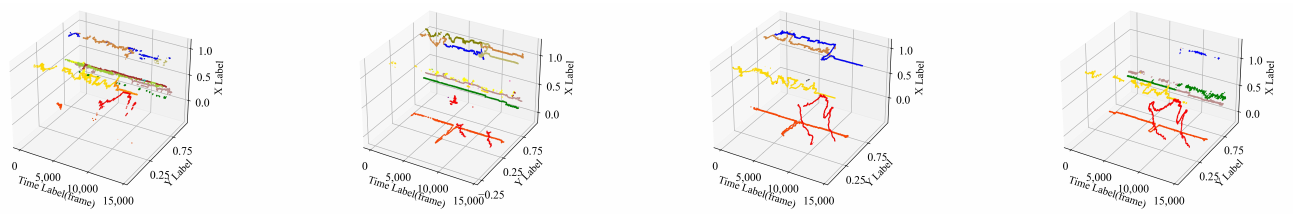
Figure 3. The 3D trajectories of different cameras (separately). The colors in each sub-figure differ among IDs.